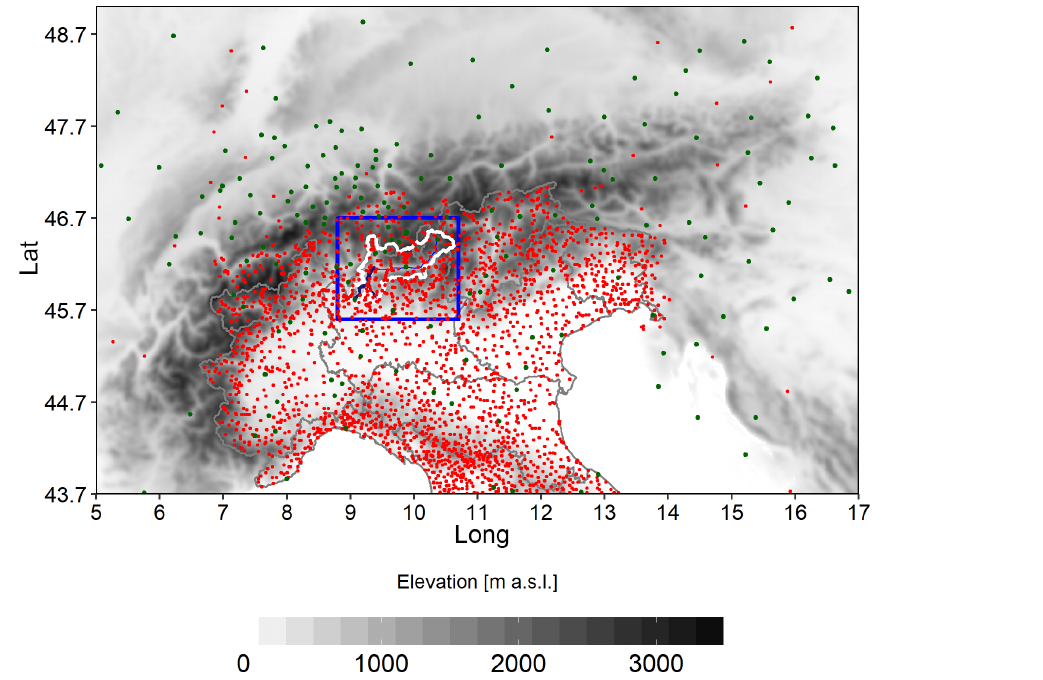
Figure 1. Distribution of the available monthly precipitation series. Study domain is contained in the blue square where the upper Adda river basin area is bordered in white. Green dots represent the stations with the longest records (more than 120 years of data).